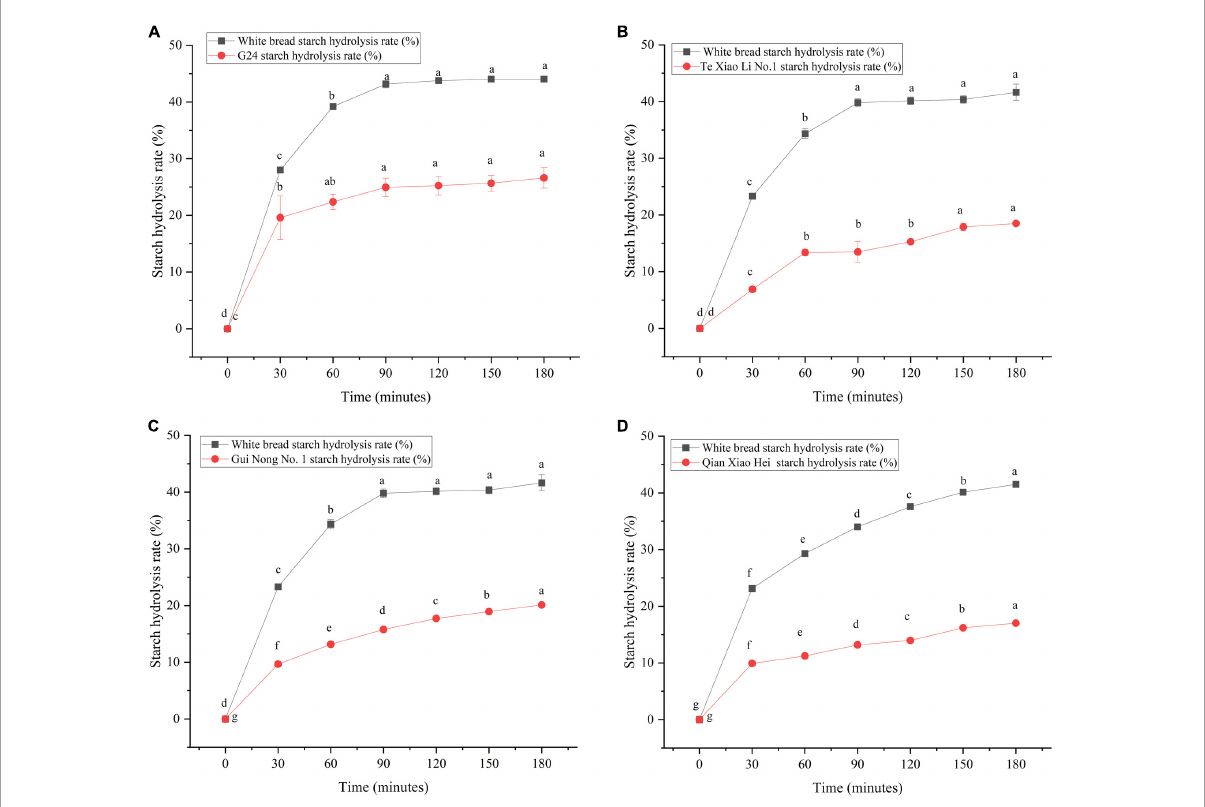
FIGURE4 Dynamic changes of starch hydrolysis rate of adzuki beans. Panel (A) exhibits the starch hydrolysis curves of G24 and white bread, panel (B) exhibits the starch hydrolysis curves of Te Xiao Li No. 1 and white bread, panel (C) exhibits the starch hydrolysis curves of Gui Nong No. 1 and white bread, and panel (D) exhibits the starch hydrolysis curves of Qian Xiao Hei and white bread. Bars in the same curves with no same letters indicate significant differences at the level of p < 0.05.